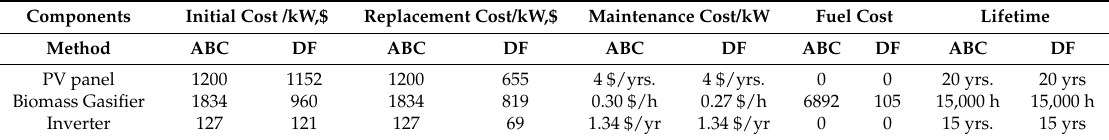
Table 3. Cost of components by dragonfly algorithm (proposed method) and the artificial bee colony (ABC) algorithm